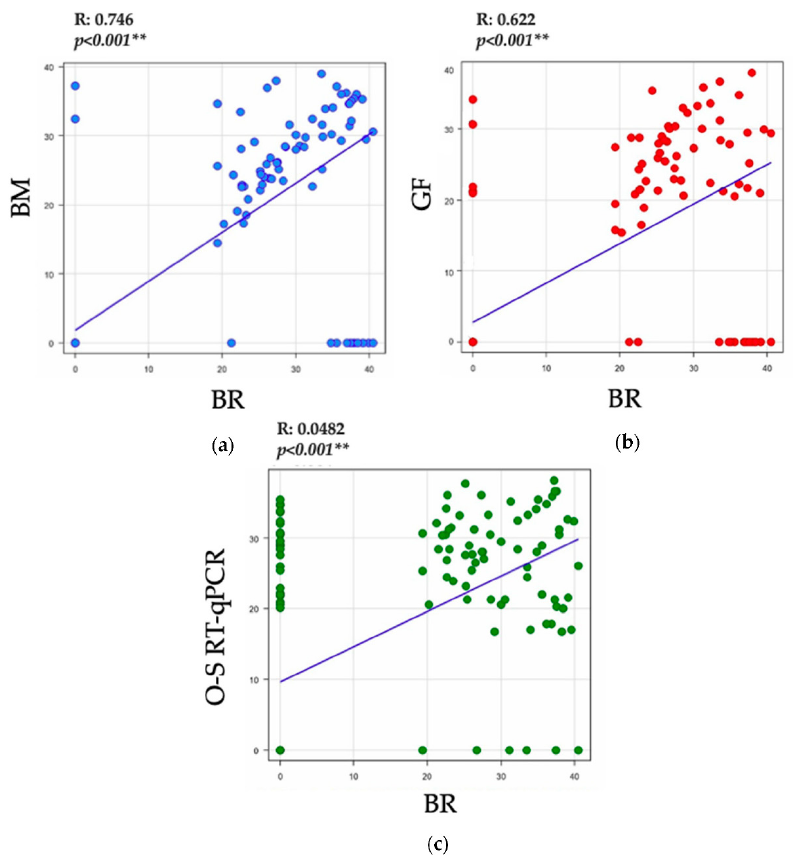
Figure 1. Correlation of Ct values between the RT-qPCR assays for the detection of the SARS-CoV2 virus. ( a ) Correlation of Ct values of E gene between the BM and BR protocols ( b ) Correlation of Ct values of E gene between the GF-TM and BR protocols ( c ) Correlation of Ct values of E gene between the O-S RT-qPCR and BR protocols. Abbreviations: GeneFinder TM COVID-19 Plus RealAmp (In Vitro Diagnostics): GF-TM; One-Step Real-Time RT-PCR (Vitro Master Diagnostica): O-S RT-qPCR; Berlin modified protocol: BM; gold-standard Berlin protocol (Berlin Charité Probe One-Step RT- ROC curve analysis indicated that the best diagnostic kit was the BM, with a